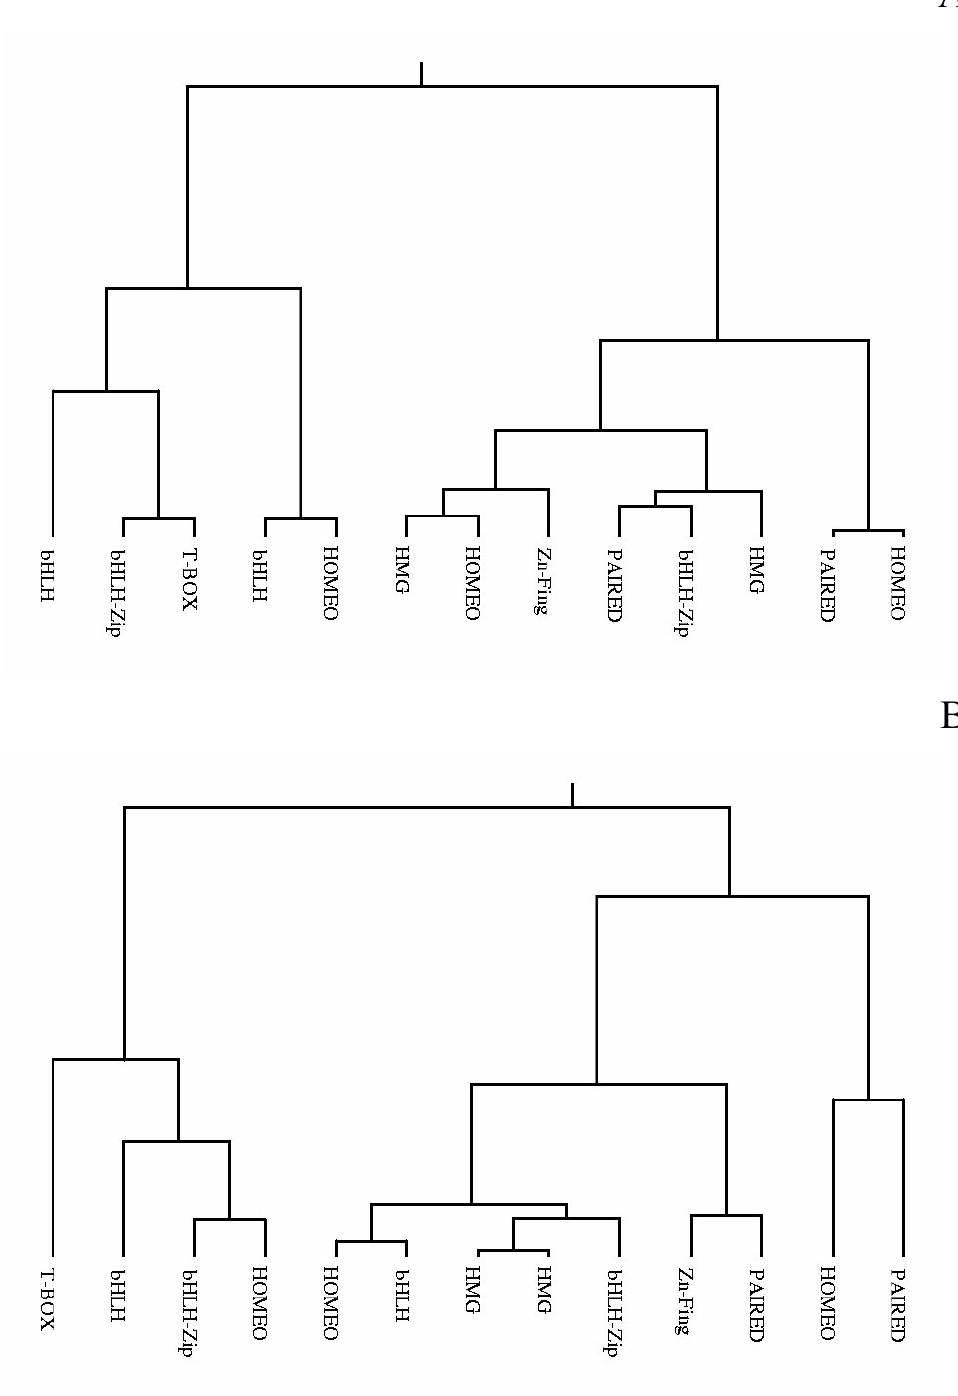
Figure 4: Functional classification of TFBS in Mouse; information content is calculated from nucleotide (A) neighbor-independent and (B) neighbor-dependent substitution